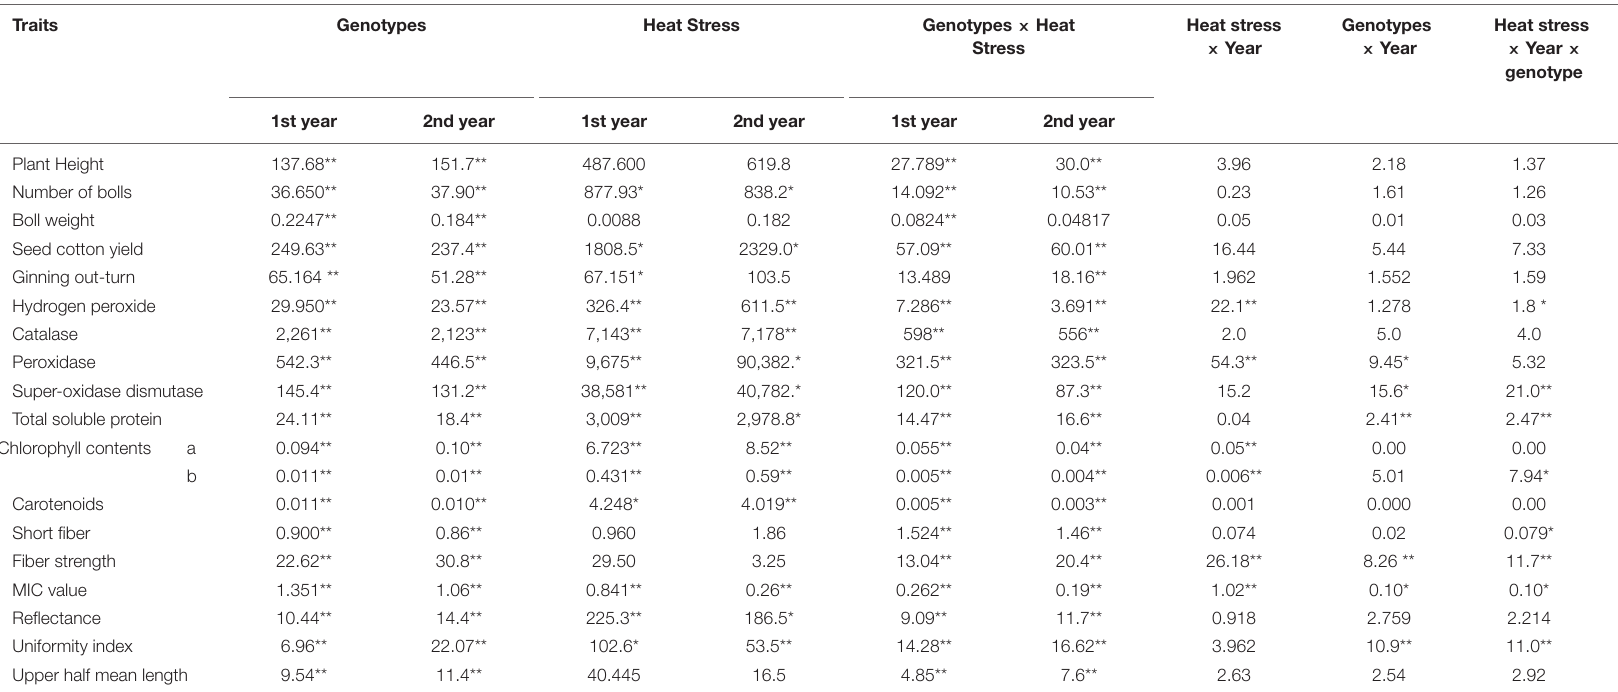
TABLE 2 | Summary of mean square values regarding the influence of high-temperature stress on different traits of the studied cotton genotypes of parents and their F 1 hybrids across the 2 experimental years.